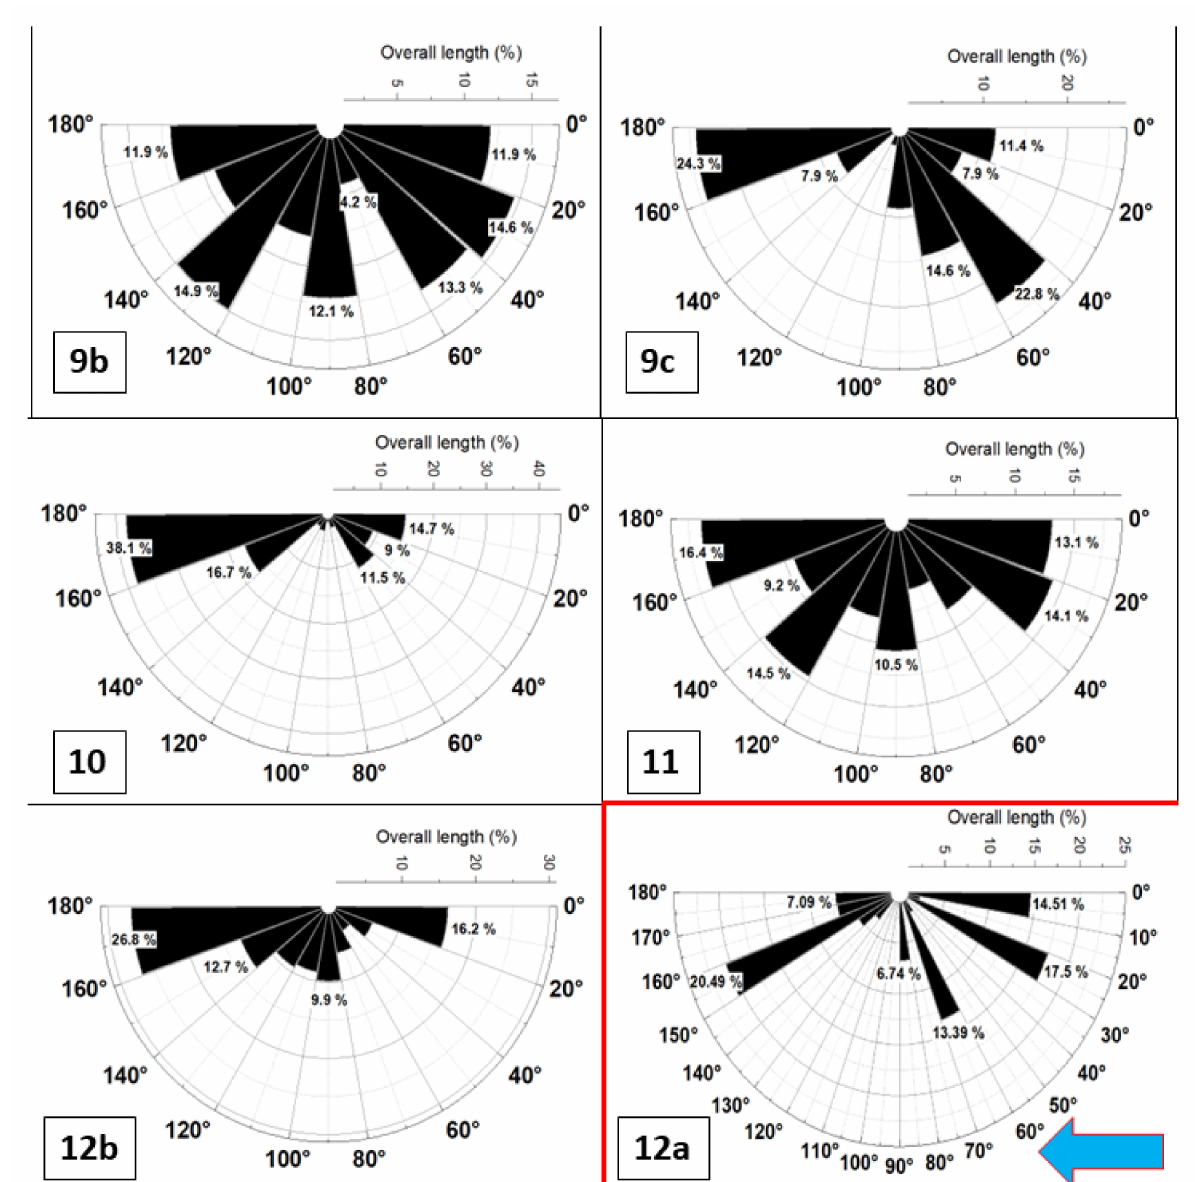
Figure 15. Situmetry of gravel clasts measuring the horizontal orientation of the longest axis of the gravel clast. The red framed example at site 12a illustrates the vertical orientation of lithoclasts. The blue arrowhead denotes the flow direction of the river. See Figure 3 for position and sampling sites which are given with the Arabic numerals in the semicircle rose diagrams. The numbers refer to the sampling